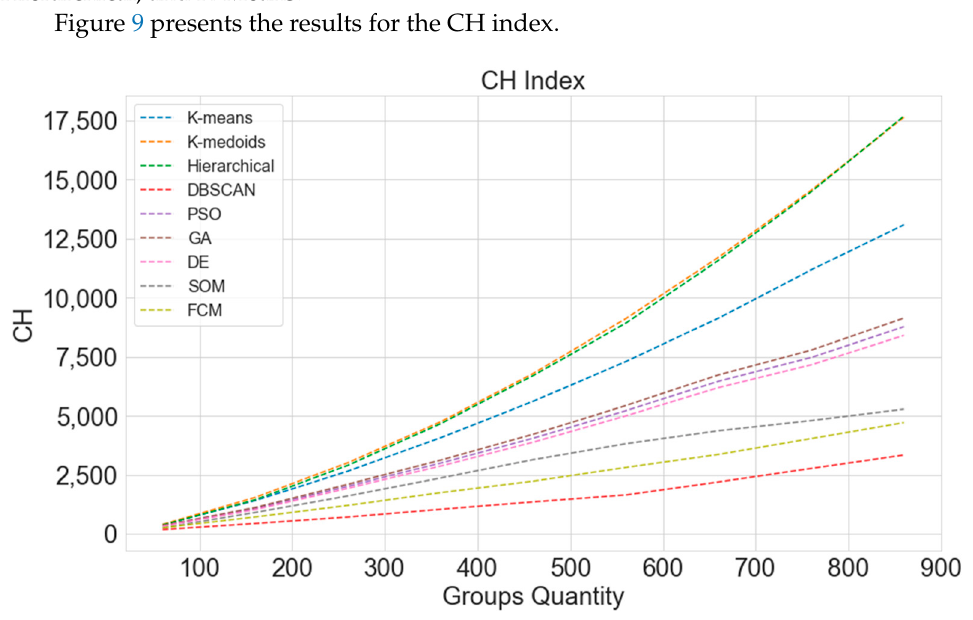
Figure 8. SSB index evaluation over different group amounts considering nine clustering methods.